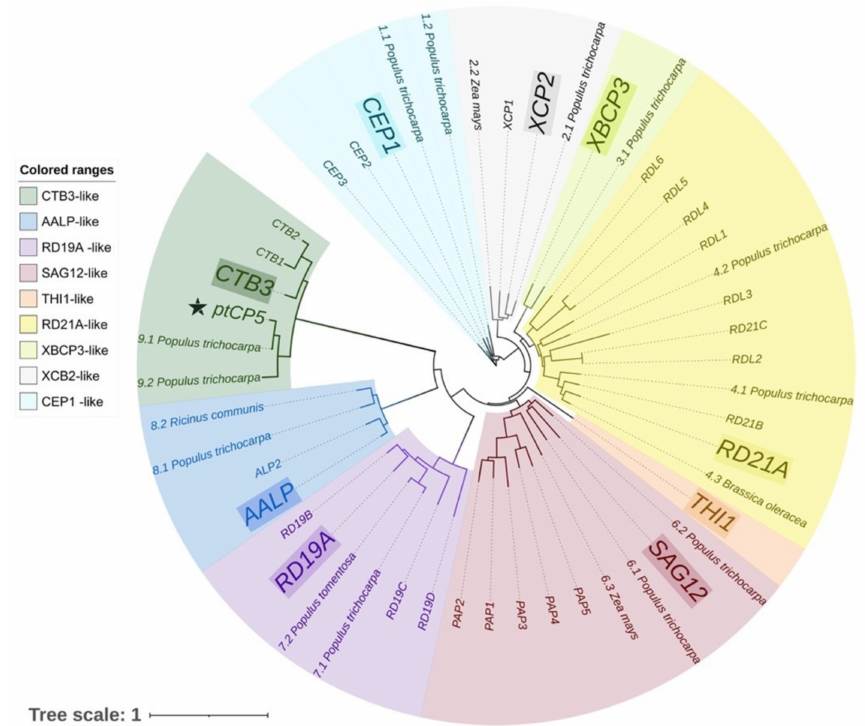
Figure 2. Phylogenetic analysis of PtCP5 based on an NJ tree with 1000 bootstrap replicates among 70 PLCPs subfamily proteins.